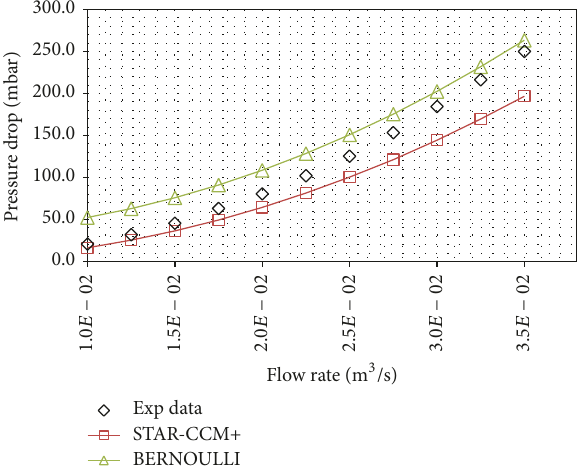
Figure 7: Results for Venturi nozzle at 200 ∘ C, experimental trend versus STAR-CCM+